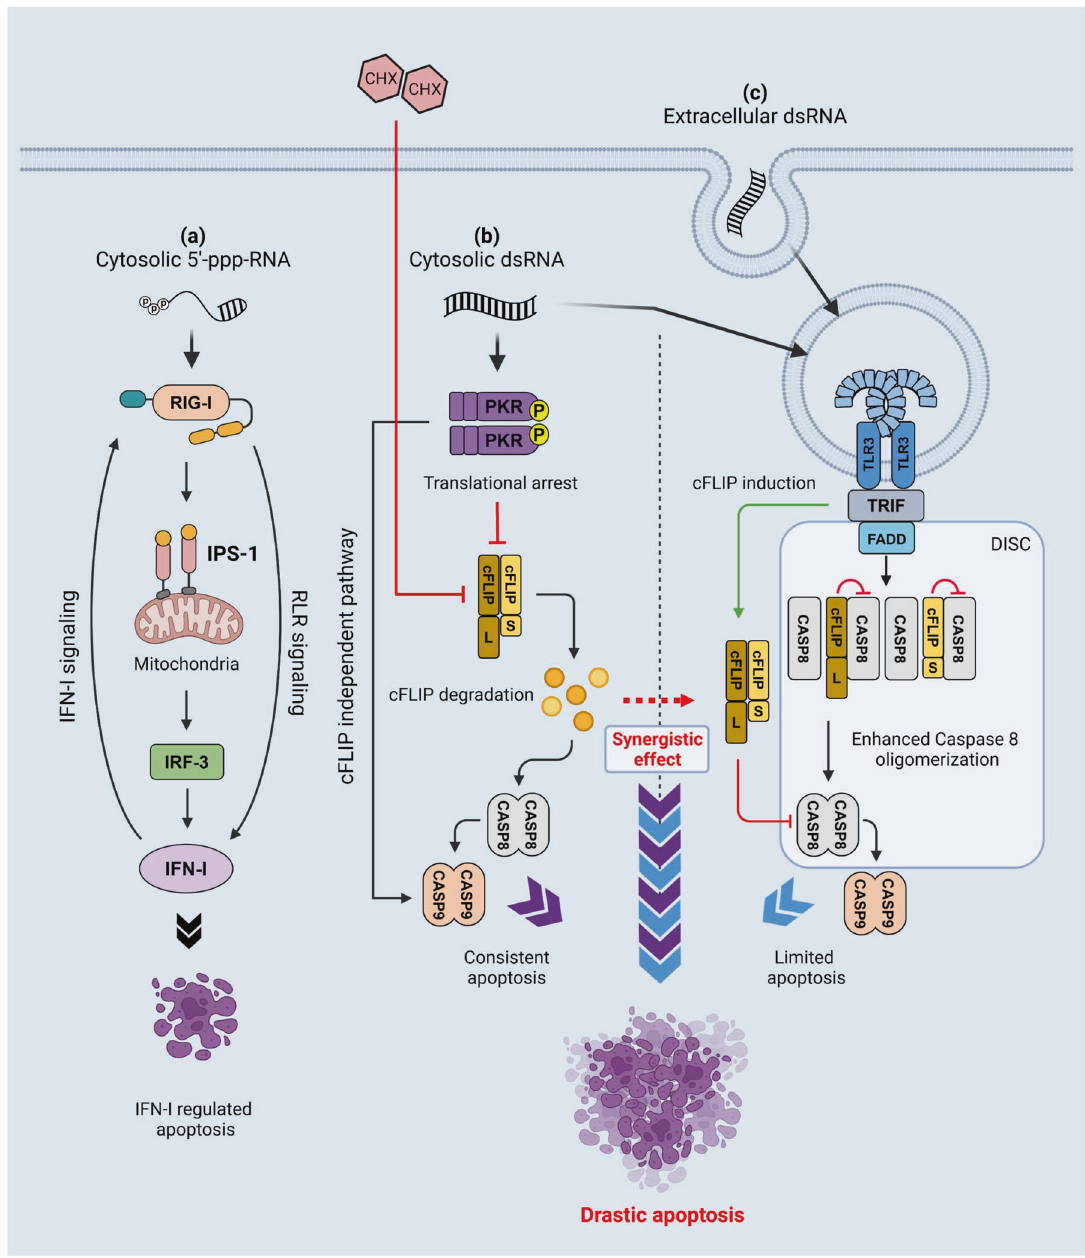
Fig. 8 Schematic view of cell death signaling induced by 5 ’ -ppp-RNA, cytosolic dsRNA, and extracellular dsRNA. a Cytosolic short 5 ’ -ppp- dsRNA is sensed by RIG-I and activates signaling, leading to the induction of IFN-I and limited apoptosis with slow kinetics. This apoptosis is dependent on genes regulated by IRF-3 and IFN-I. b Cytosolic dsRNA introduced by the injection or transfection activates TLR3 through endosomal entrapment as above. In contrast to endosomal dsRNA, cytosolic dsRNA activates PKR, which results in the induction of SG and translational shutdown, leading to the downregulation of cFLIP and apoptosis through the activation of caspase 8. In addition, PKR was reported to promote the mitochondrial pathway in order to activate caspase 9; therefore, robust apoptosis was induced via caspases 8/9. c Extracellular dsRNA is incorporated by endocytosis and sensed by TLR3. TLR3 signals TRIF and activates signaling, leading to the induction of IFN-I and the expression of cFLIP in order to negatively regulate caspase 8. The TLR3 signaling complex also recruits FADD to activate DISC containing caspase 8; however, due to the effects of cFLIP, apoptosis is suppressed. When cells are treated with extracellular dsRNA and CHX, caspase 8 promotes apoptosis because of the downregulation of